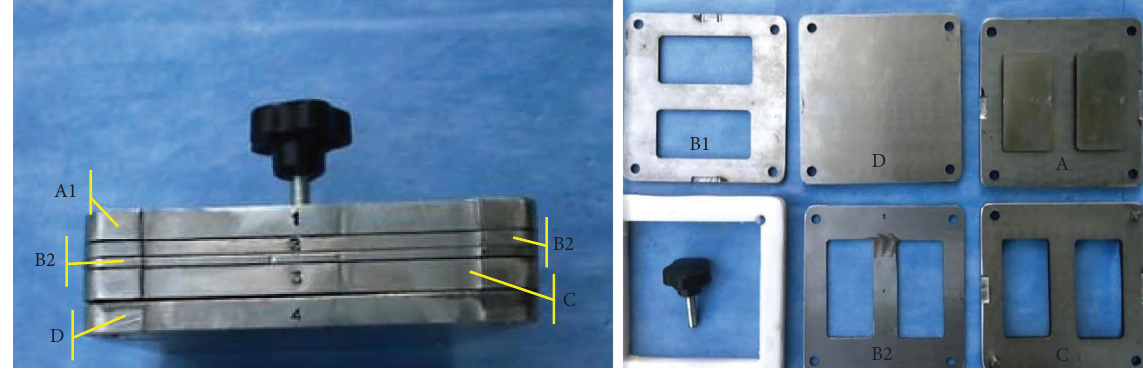
Figure 1: Parts of